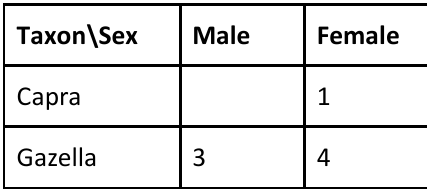
Figure 6: First phalanx distal breadth measurement distribution for caprines and gazelles, all layers. Table 7: Sex frequencies by pubis bone